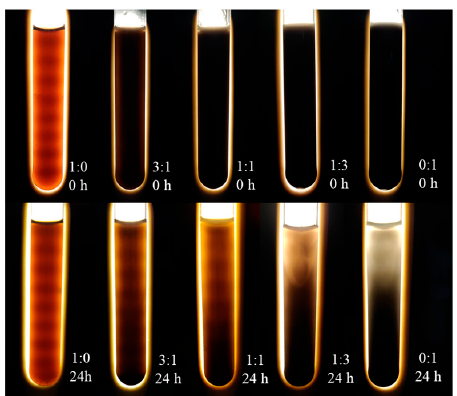
Figure 5. Dispersion of GO / GR hybrid just stirred and stood for 24 h.